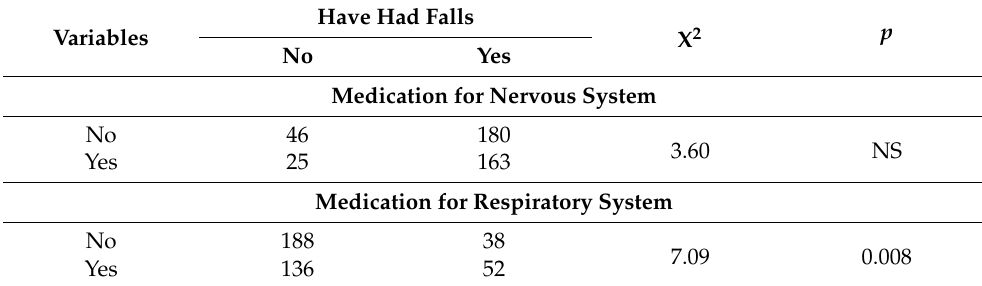
Table 7. Relationship between having had falls and the type of medication consumed.